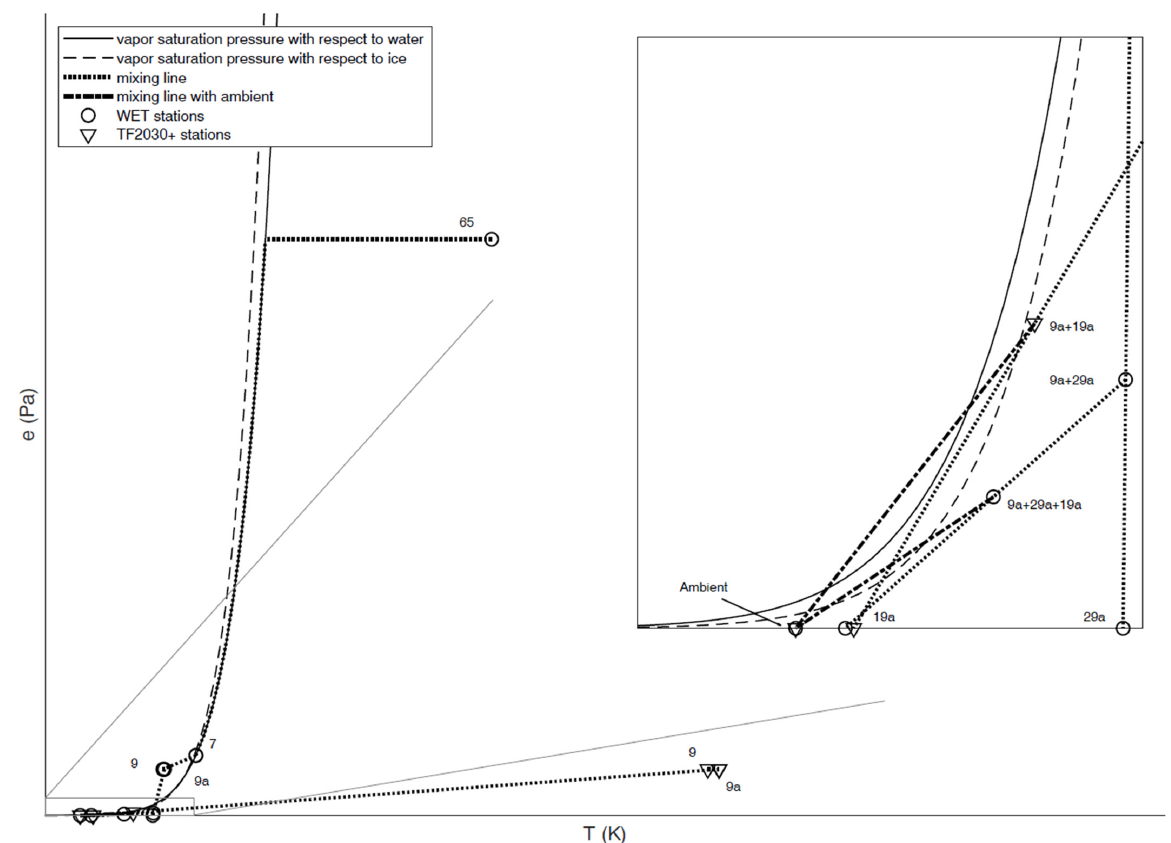
Figure 5. Partial pressure of water 𝑒 over temperature 𝑇 at different engine stations. Circles refer to the WET concept, and triangles to the reference TF2030+. Mixing of the core and bypass air is shown by dotted lines. Mixing of the engine plume with ambience is shown with a dashed–dotted line. Ambient conditions are ISA at 35.000 ft with dry air. While the TF2030+ would produce con- trails, no contrails would form for the WET concept.